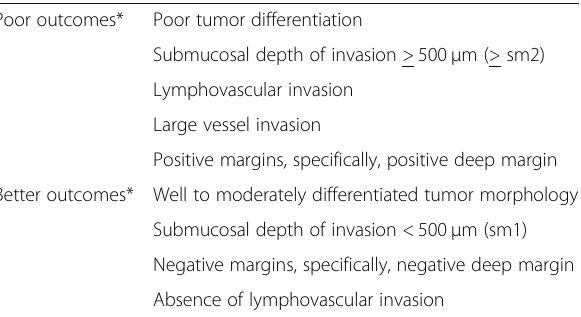
Table 7 Pathologic variables associated with poor outcomes and better outcomes in ESD